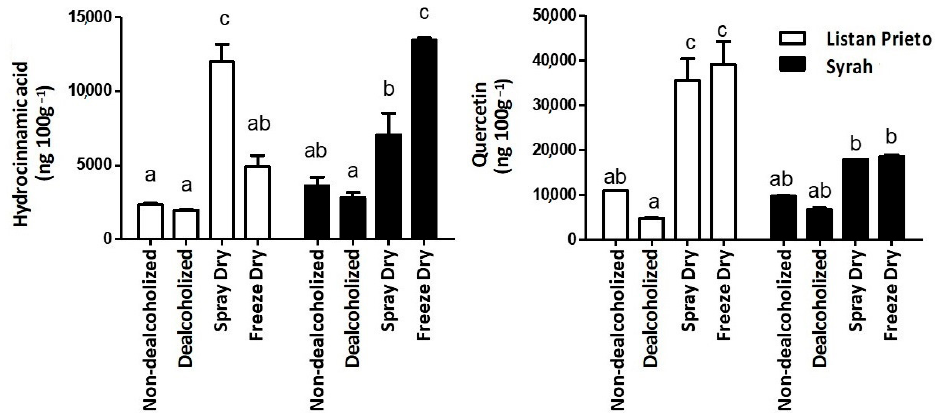
Figure 2. Interaction between wine variety and treatment (A × B) on hydrocinnamic acid and quercetin content in non-dealcoholized (control), dealcoholized and powdered wines made by freeze dry and spray dry from Listan Prieto (white bars) and Syrah (black bars) wine varieties. Different letters represent statistically significant differences among treatments and wine variety.